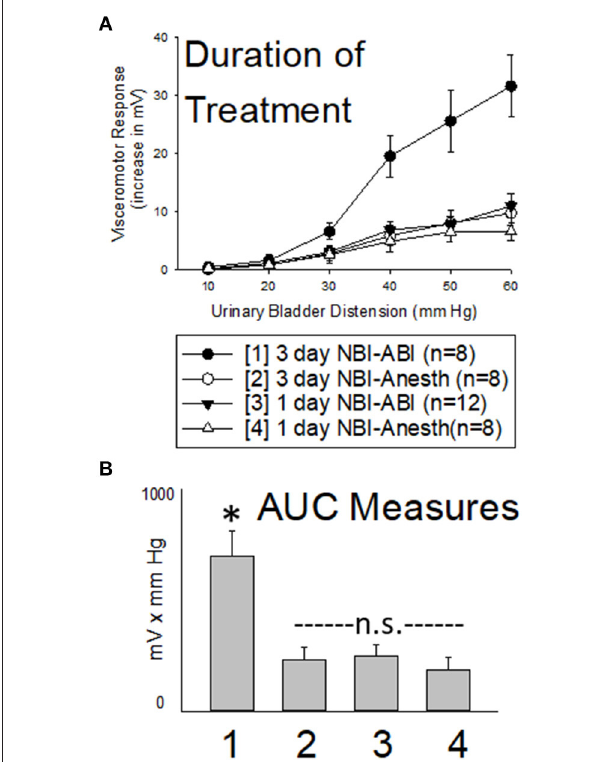
FIGURE 4 | Effect of Altering Duration of Neonatal Bladder Inflammation (NBI) Treatment. Data presented in same fashion as panels in Figure 2 (group stimulus-response functions in (A) ; Area-Under-the-Curve, AUC, measures in (B) ). Three days of NBI treatment followed by adult bladder inflammation (ABI) resulted in statistically more robust visceromotor responses when compared with all other groups tested. Stated statistics represent ANOVA results. * indicates 3 day NBI group different from all other groups ( p < 0.05) for data point indicated; “n.s.” indicates non-significant difference from other groups indicated.